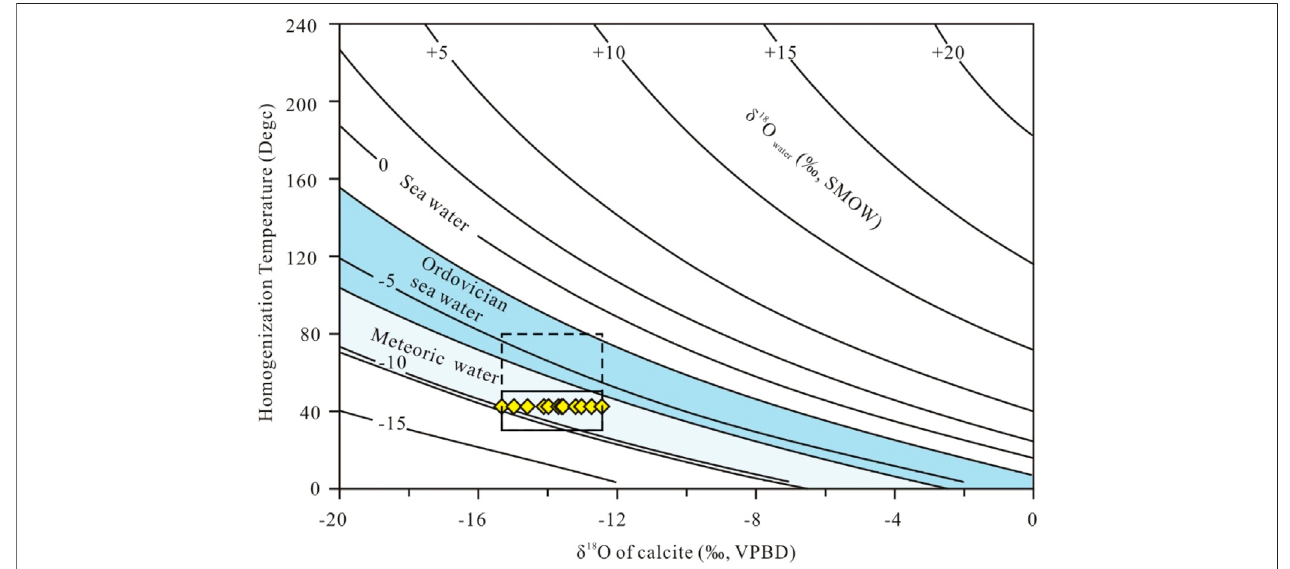
FIGURE 12 | Temperature versus δ 18 O diagenetic fl uid for δ 18 O values of CFC using the calcite-water equation (10) 3 ln α calcite-water = 2.78 × 10 6 T − 2 − 2.89 (O ’ Neil et al., 1969). Solid box represents that the parent fl uids is meteoric water with δ 18 O water values ( − 13.8 to 5.8) when the temperature is 30 ° C – 50 ° C.Dashed box indicates that the parent fl uid is Ordovician seawater with δ 18 O water values ( − 5.8 to 2.2) when the temperature is 50 ° C – 75 ° C.